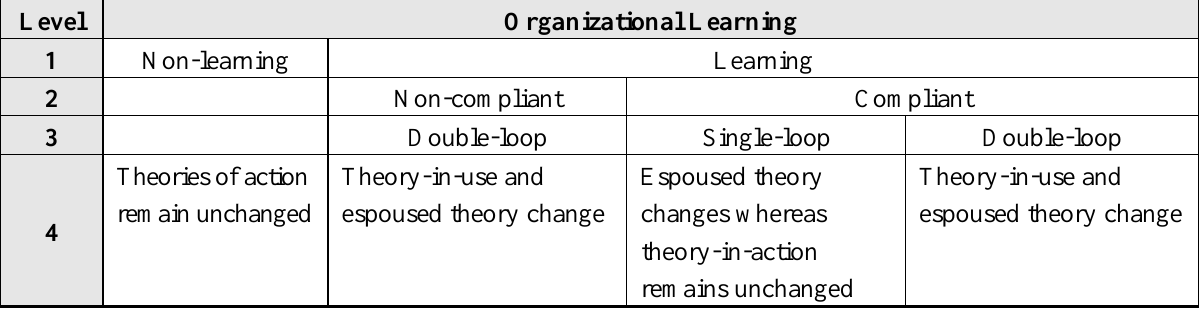
Table 1. Levels of Organizational